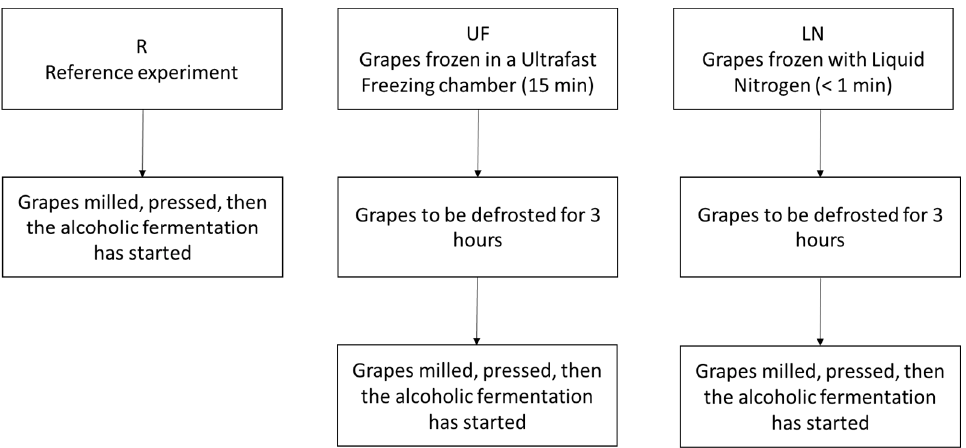
Figure 1. Winemaking processes for the three types of wine: R (reference), UF (ultra fast mechanical freezing) and LN (liquid nitrogen freezing).